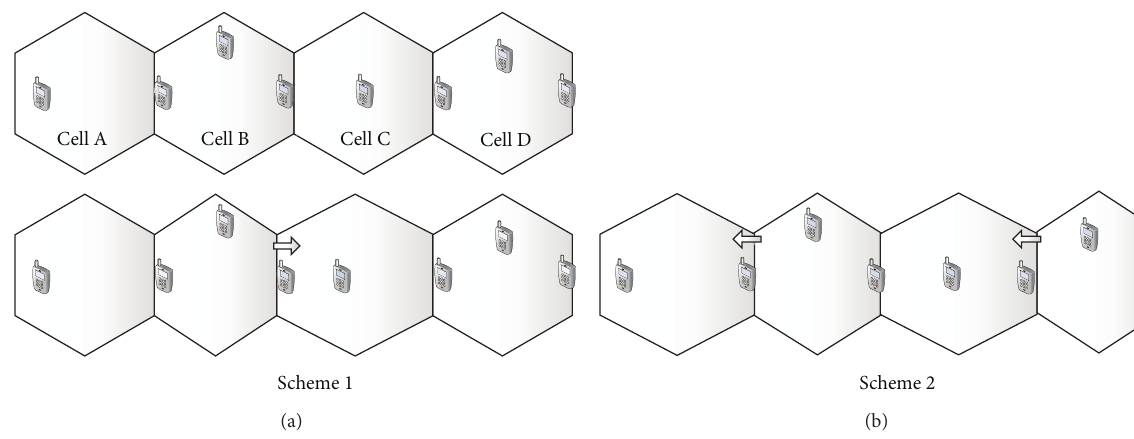
Figure 4: A LB scenario and two corresponding schemes.